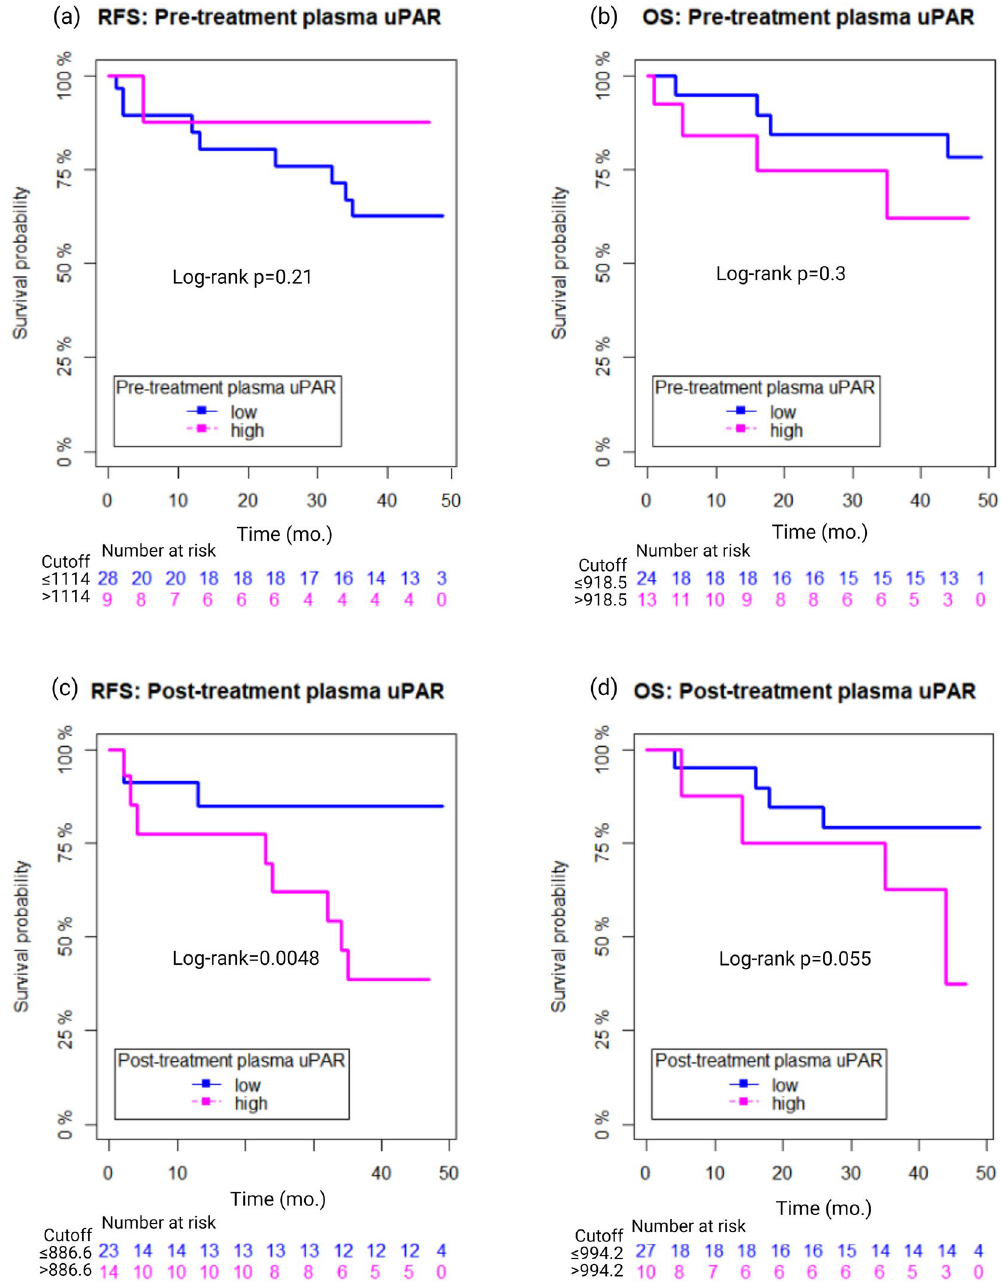
Figure 2. Survival outcomes in head- and neck cancer patients according to plasma uPAR levels pre- and post- radiotherapy treatment. Relapse-free- (RFS) and overall survival (OS) for plasma uPAR measured pre-treatment ( a and b ) and post-treatment ( c and d ), respectively, according to the established